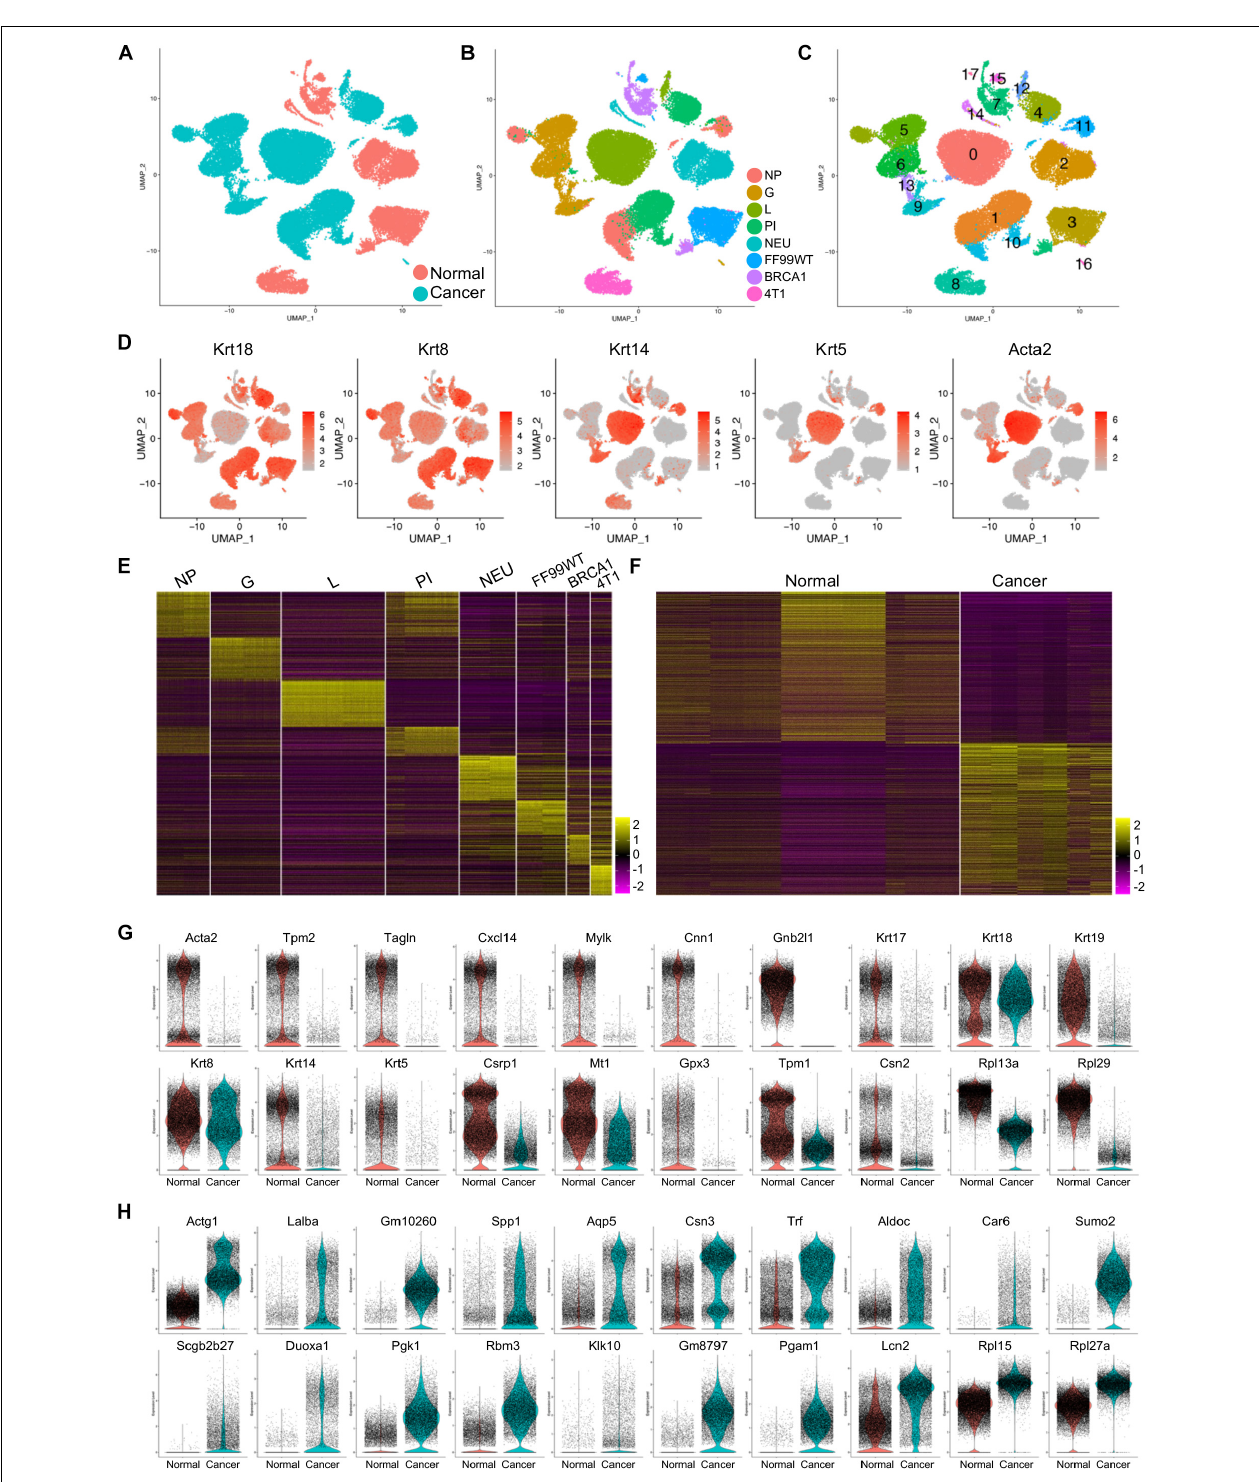
FIGURE 1 | Gene expression patterns of the cancer cells and normal epithelial cells. (A,B) Distribution of normal and cancer cells (A) and cells from different developmental stages and mouse models (B) in the merged data. (C) Identification of the major cell clusters in the merged scRNA-seq data. (D) Transcription of the canonical luminal marker genes and basal marker genes in the merged data. (E,F) Heatmap visualization of the top 100 genes of cells from each developmental stage and breast cancer mouse model (E) and the top 500 genes of the normal epithelial cells and cancer cells (F) . (G,H) Violin plot presentation of the top 20 genes upregulated in normal (G) or cancer (H)